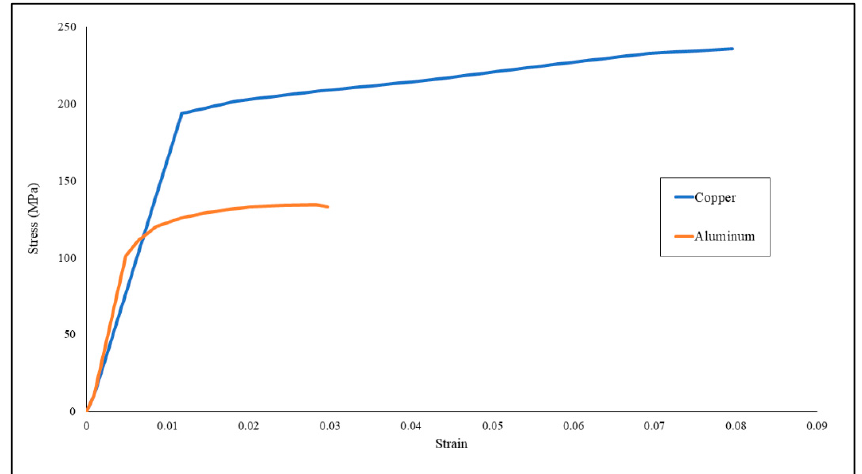
Figure 5. Stress–strain curve for the steel casing on different values of strain rate in ms -1 .